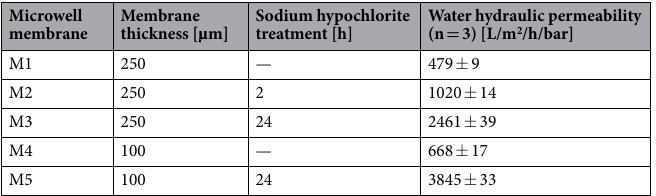
Table 1. Membrane water